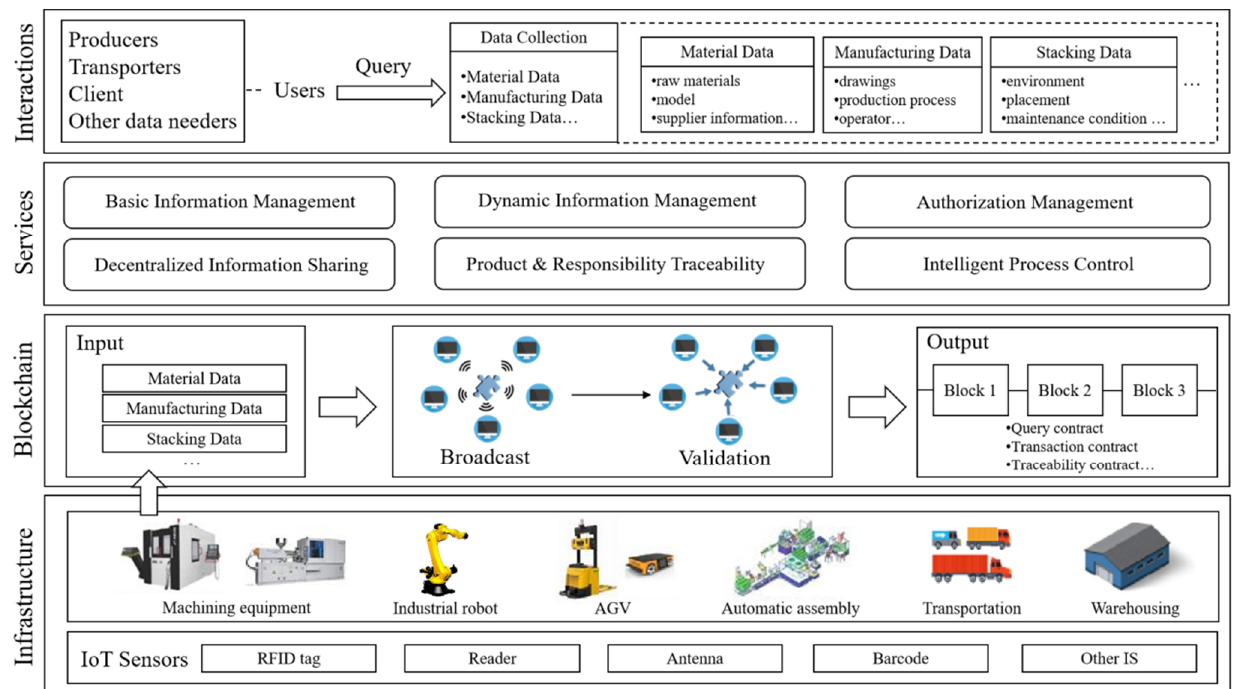
Figure 4. Reference framework of blockchain technology ‐ enabled smart manufacturing.